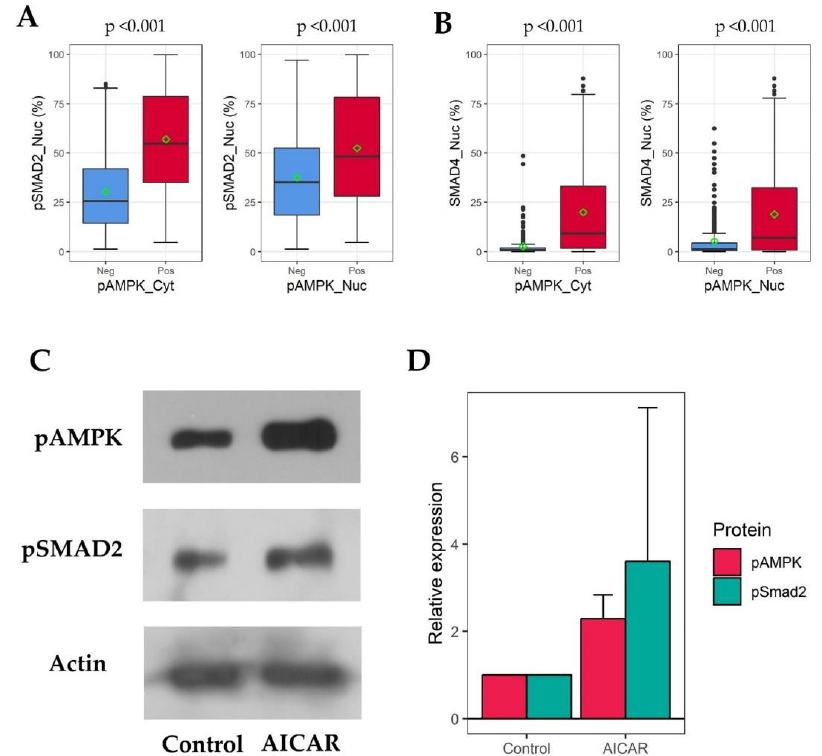
Figure 3. pSMAD2 / SMAD4 upregulation by pAMPK in ccRCC. pAMPK-positive ccRCC, either in the cytoplasm or nuclei, shows higher nuclear expression levels of ( A ) pSMAD2 and ( B ) SMAD4 than pAMPK-negative ccRCC (Mann–Whitney U tests). Green square indicates the mean value; ( C ) AICAR activates pAMPK and induces pSMAD2 expression in Caki-1 cells; ( D ) The relative intensity of Western blot results before (control) and after AICAR treatment is shown as a mean (bar) with a standard deviation (line) (Rex 3.0.4, RexSoft Inc., Seoul, Korea).